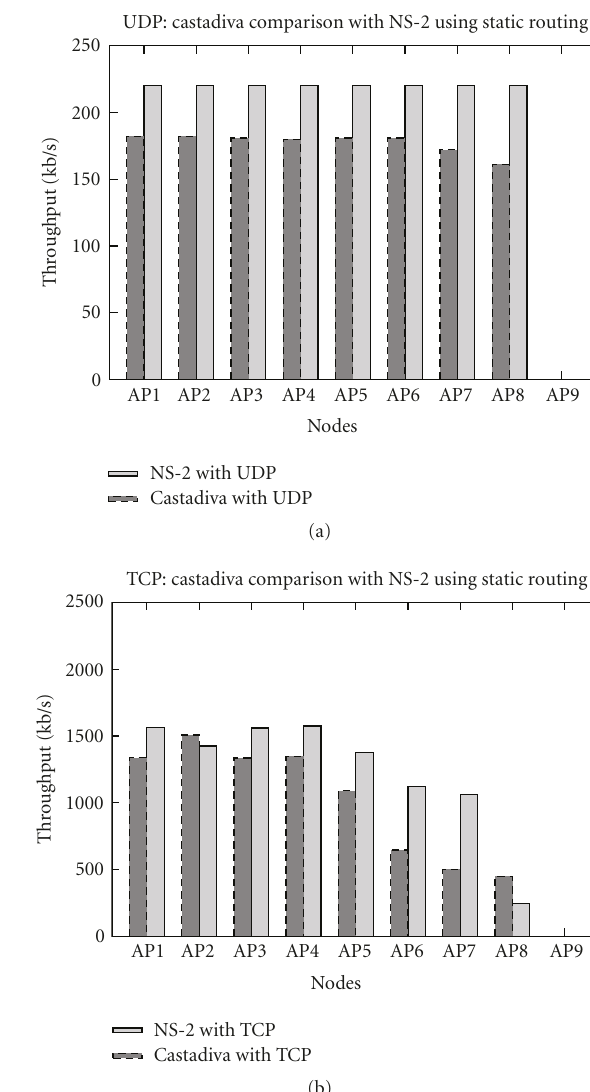
Figure 14: Performance comparison between Castadiva with ns-2 in a static scenario. Using CBR/UDP tra ffi c (a) and FTP/TCP tra ffi c (b). Routing